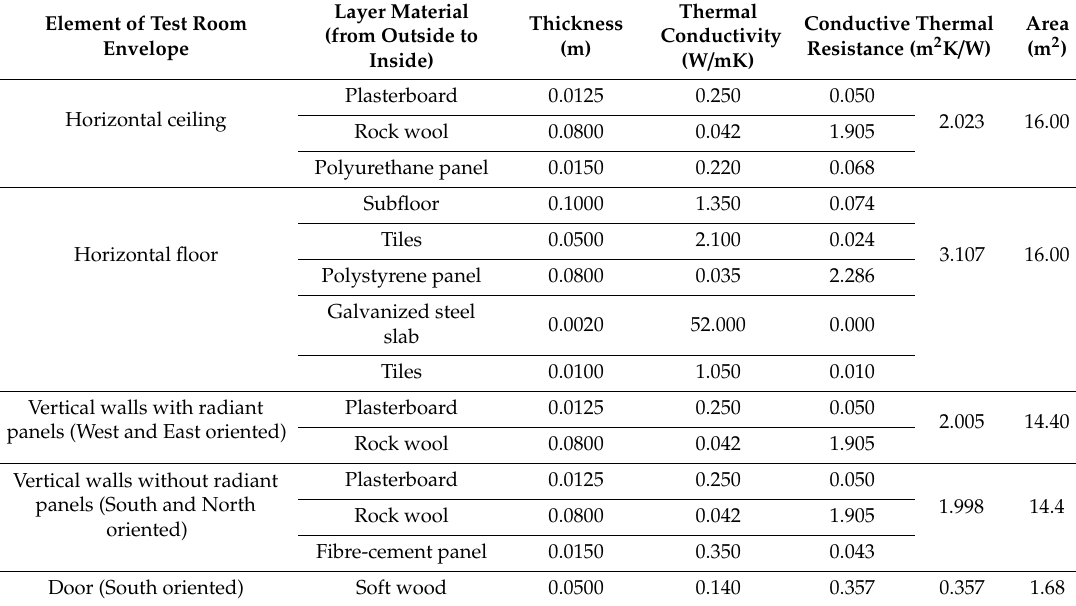
Table 1. Test room envelope characteristics of the Integrated Test Room.